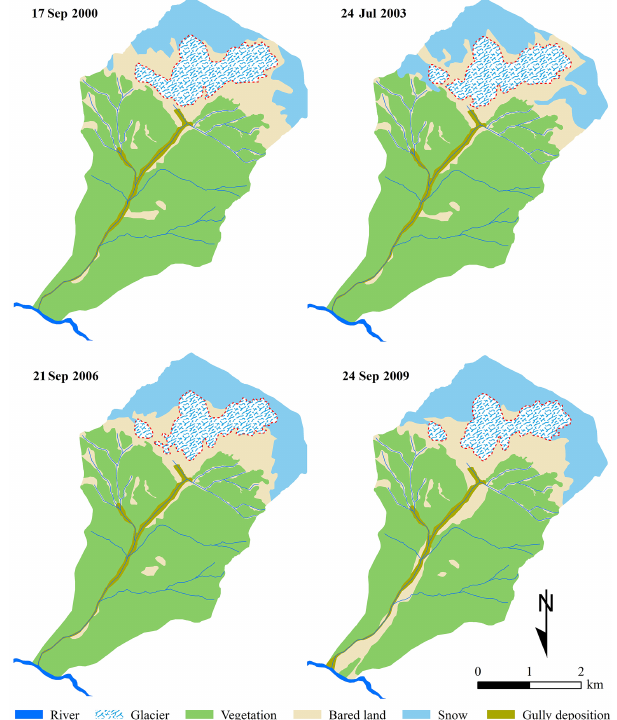
Figure 8. Air temperature and rainfall before and after DF1, DF2 and